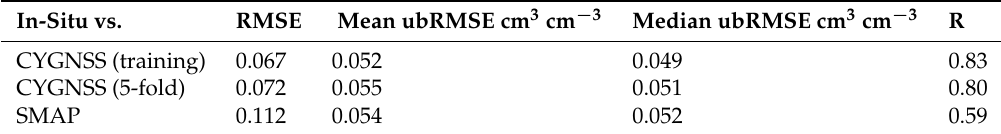
Table 2. Performance at in-situ